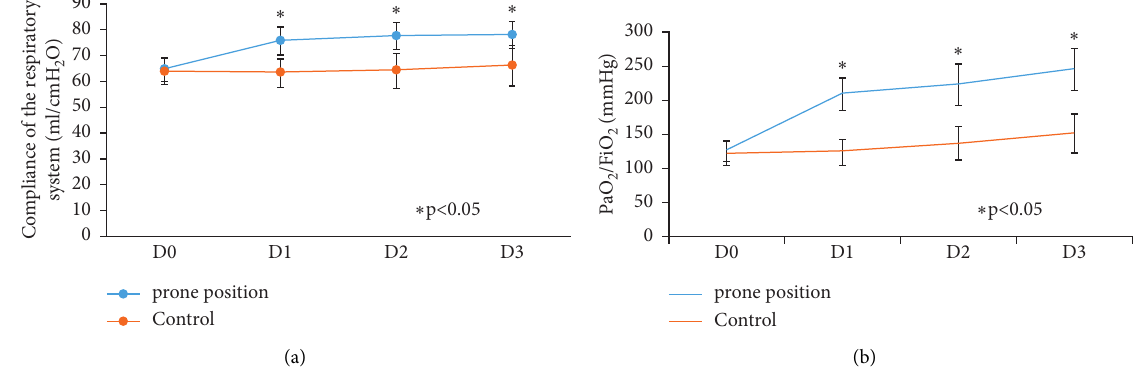
Figure 2: Changes in compliance of the respiratory system and PaO (b) trend of change in PaO 2 /FiO 2